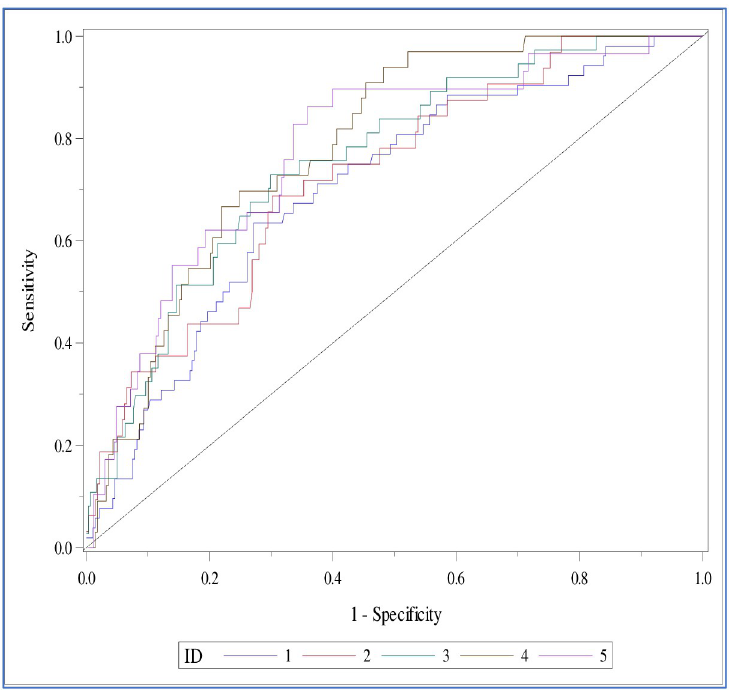
Fig 2. The ROC curves for the validation datasets for the five-fold